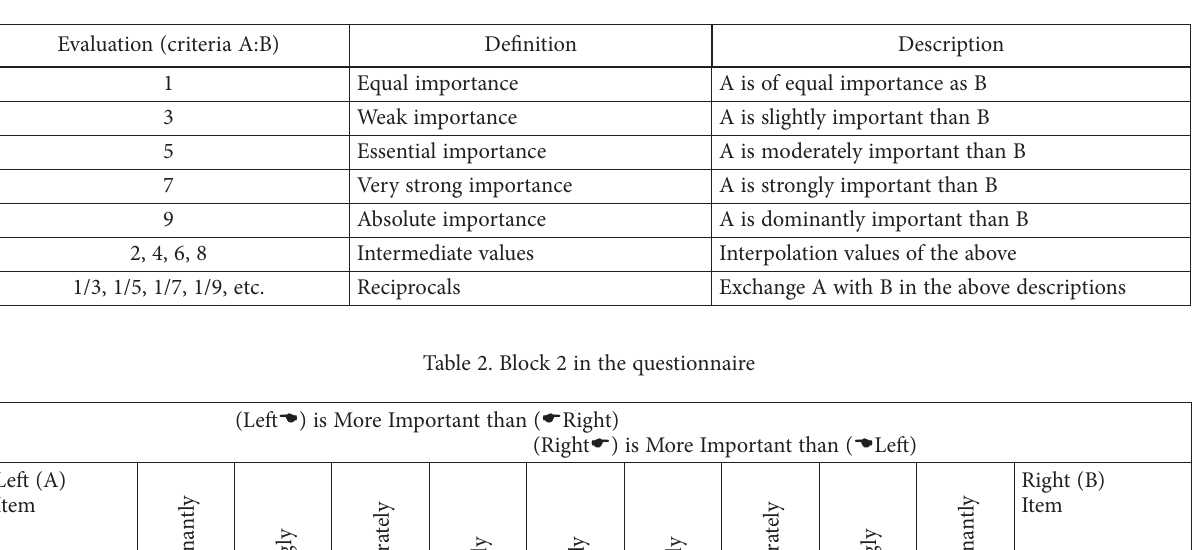
Table 1. Evaluation scales when comparing constructs/factors A and B